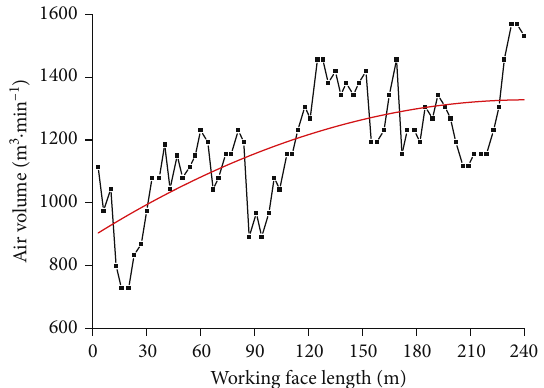
Figure 5: Air volume along the I2101 working